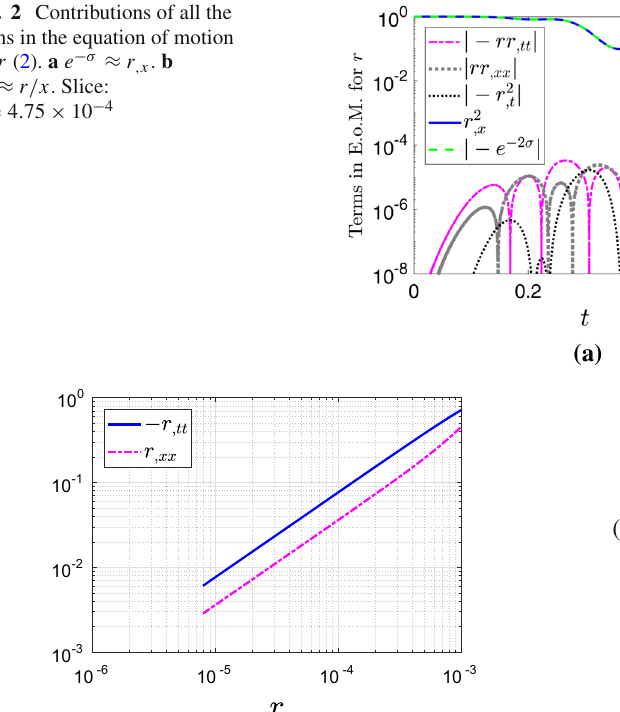
to critical collapse by pondering the amplitude and period